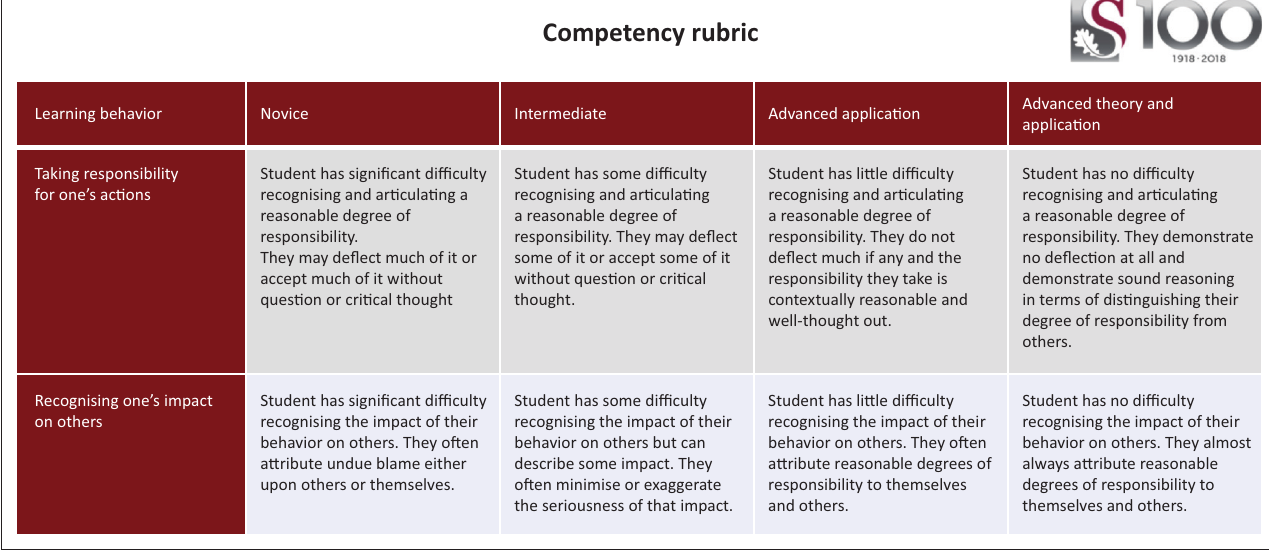
Competency rubric